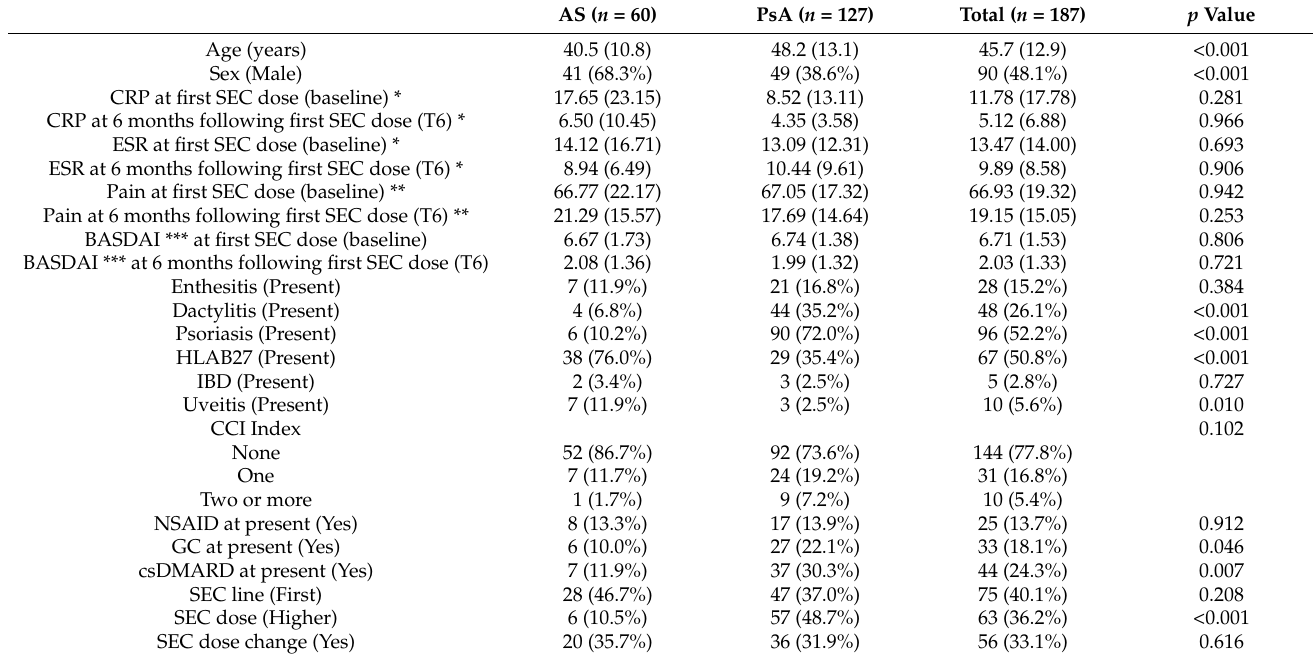
Table 1. Baseline comparison of patients with ankylosing spondylitis and psoriatic arthritis treated with secukinumab including both first- and second-line cases.